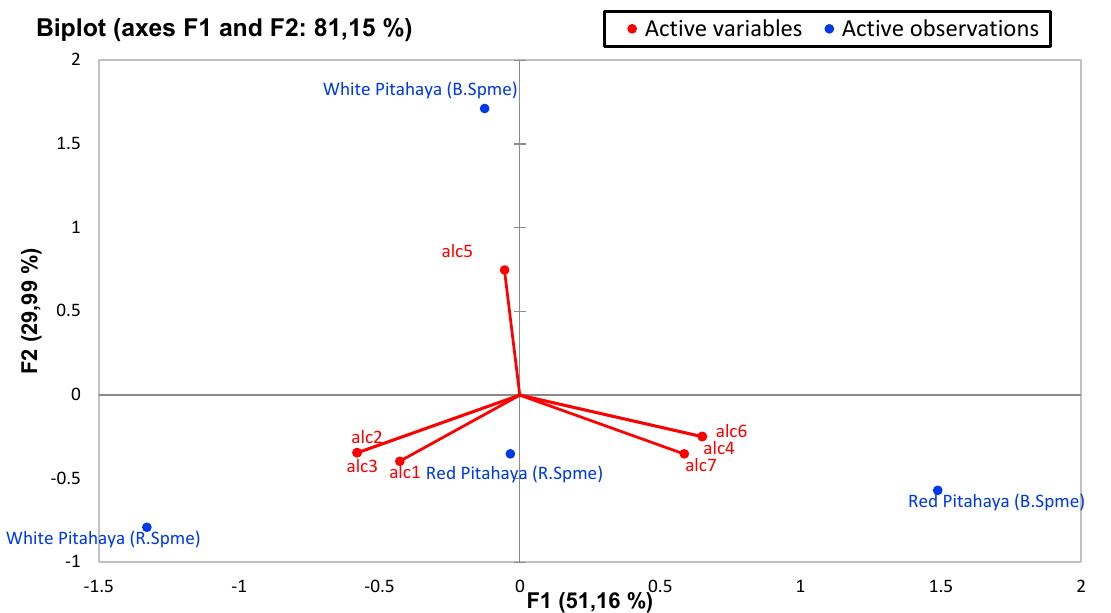
White Pitahaya (R.Spme)